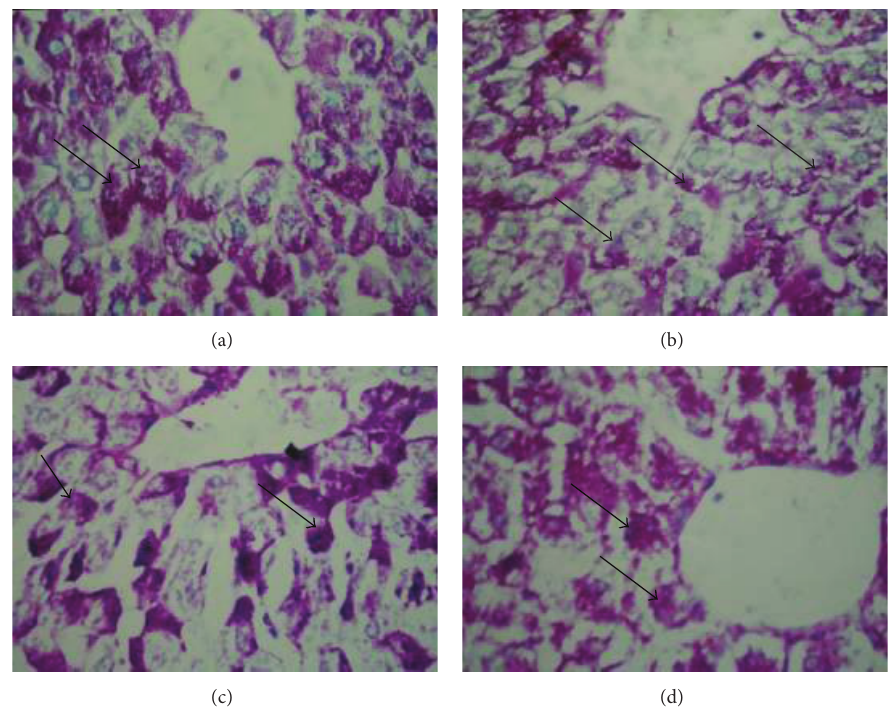
Figure 2: A photomicrograph of section of liver showing the following. (a) Control: the glycogen particles appear accumulated (arrowhead) in the cytoplasm. (b) Rats injected with METH showing the polysaccharides inclusions that displayed diffuse stain ability (arrowhead). A few number of the hepatocytes display dense stain ability compared to the others. (c) Rats injected with METH in combination with chlorogenic acid showing the polysaccharides inclusions (arrowhead) that appear more or less as control (PAS × 300). (d) Rats injected with METH in combination with caftaric acid showing the polysaccharides inclusions (arrowhead) that appear more or less as control (PAS ×